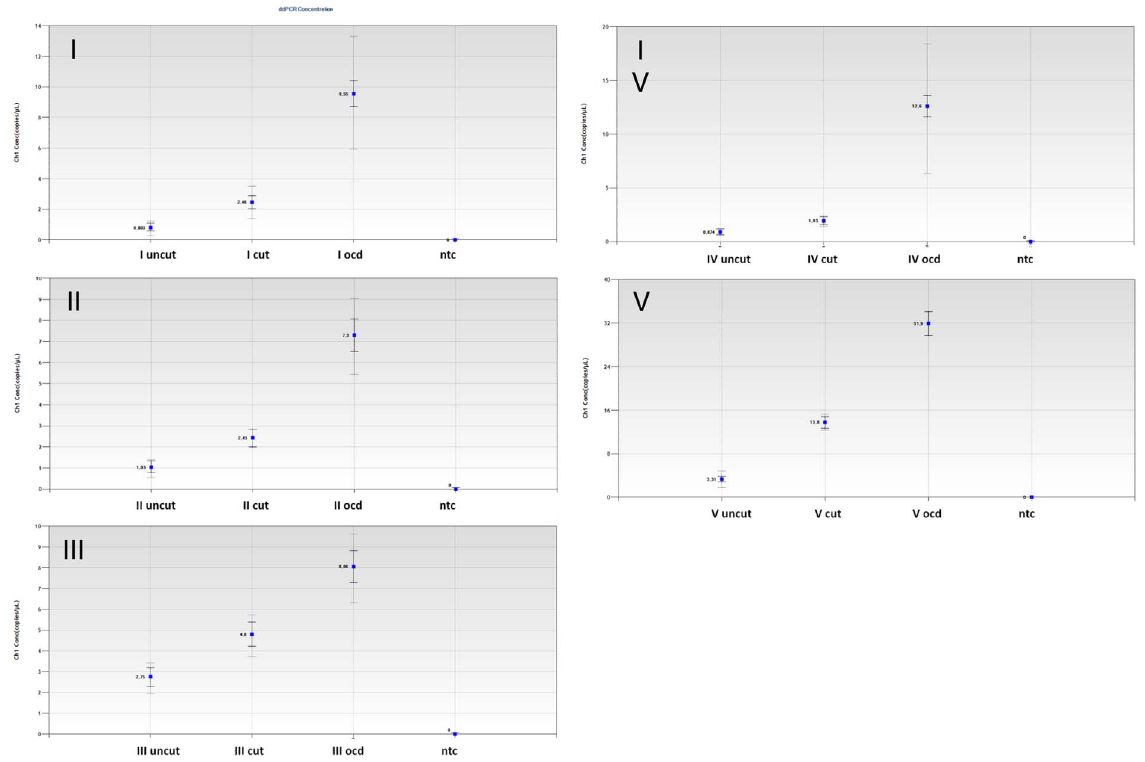
Figure 3. DdPCR results following 3 different DNA extraction procedures. Blood of 5 donors was spiked with the same amount of circular plasmid containing the IGF1 coding sequence. DNA was extracted using 3 different procedures: uncut, DdeI and RsaI cut, and on-column DdeI and RsaI digested (ocd). Results are displayed as copies detected per m l for 5 subjects (I–V for uncut; conventionally digested (cut), on-column digested DNA (ocd), and no-template control (ntc). Results derive from two independent experiments performed in duplicates.